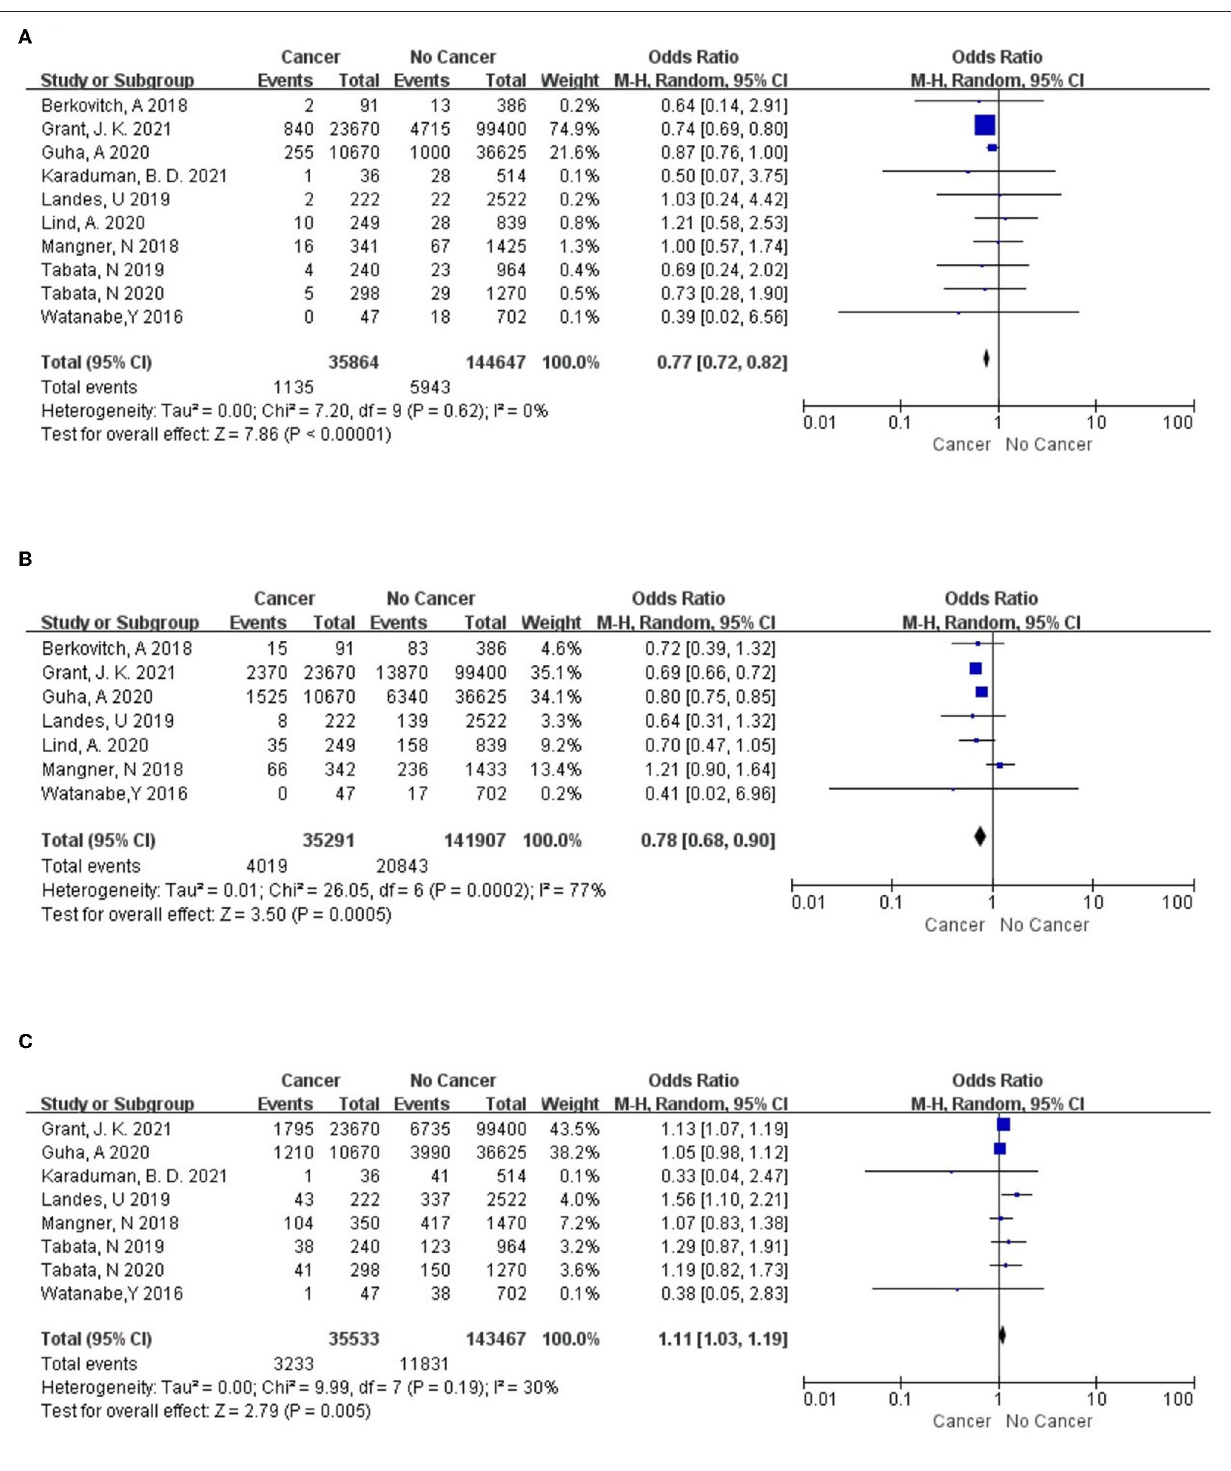
therapy based on clinical experience and the patient’s actual situation. Although patients in the cancer group are more likely to have hypercoagulable blood due to their tumors, routine